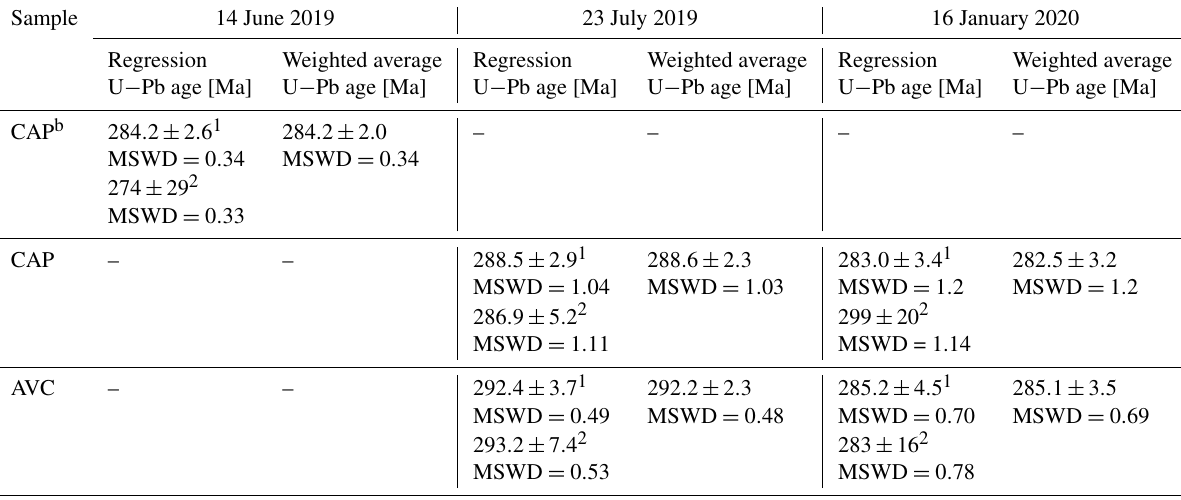
Table 3. U − Pb LA-ICP-MS ages of allanite secondary reference materials measured in three analytical sessions in this study. Age uncer- tainties are 95%